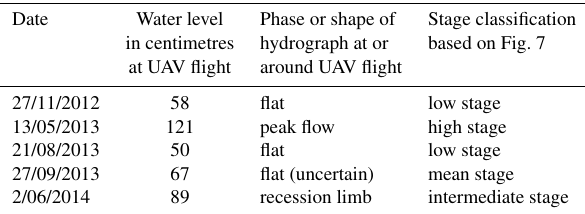
Table 2. Water levels in Gorzuchów during the UAV flights on 27 November 2012, 13 May 2013, 21 August 2013, 27 Septem- ber 2013 and 2 June 2014 along with description of hydrograph features and stage